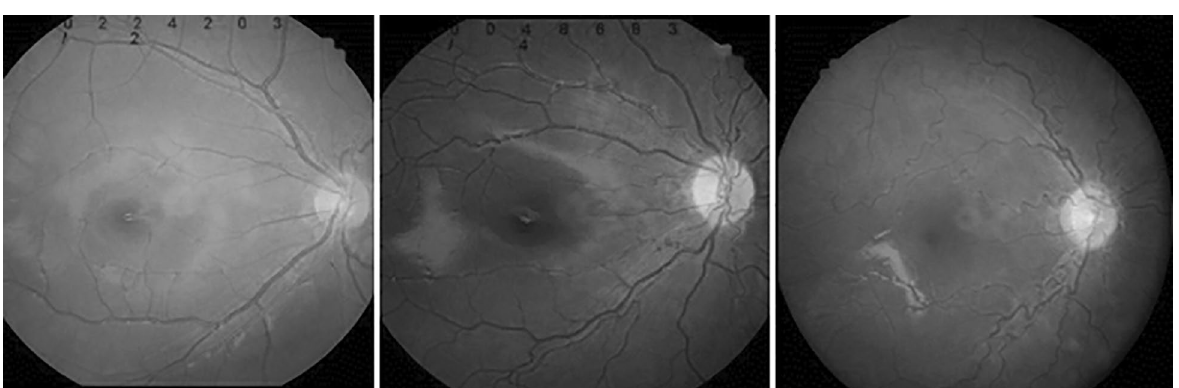
Figure 2. Macular dragging, straightening of the retinal vessels arising from the optic disc, and narrowing of the angle between major vessels are shown.